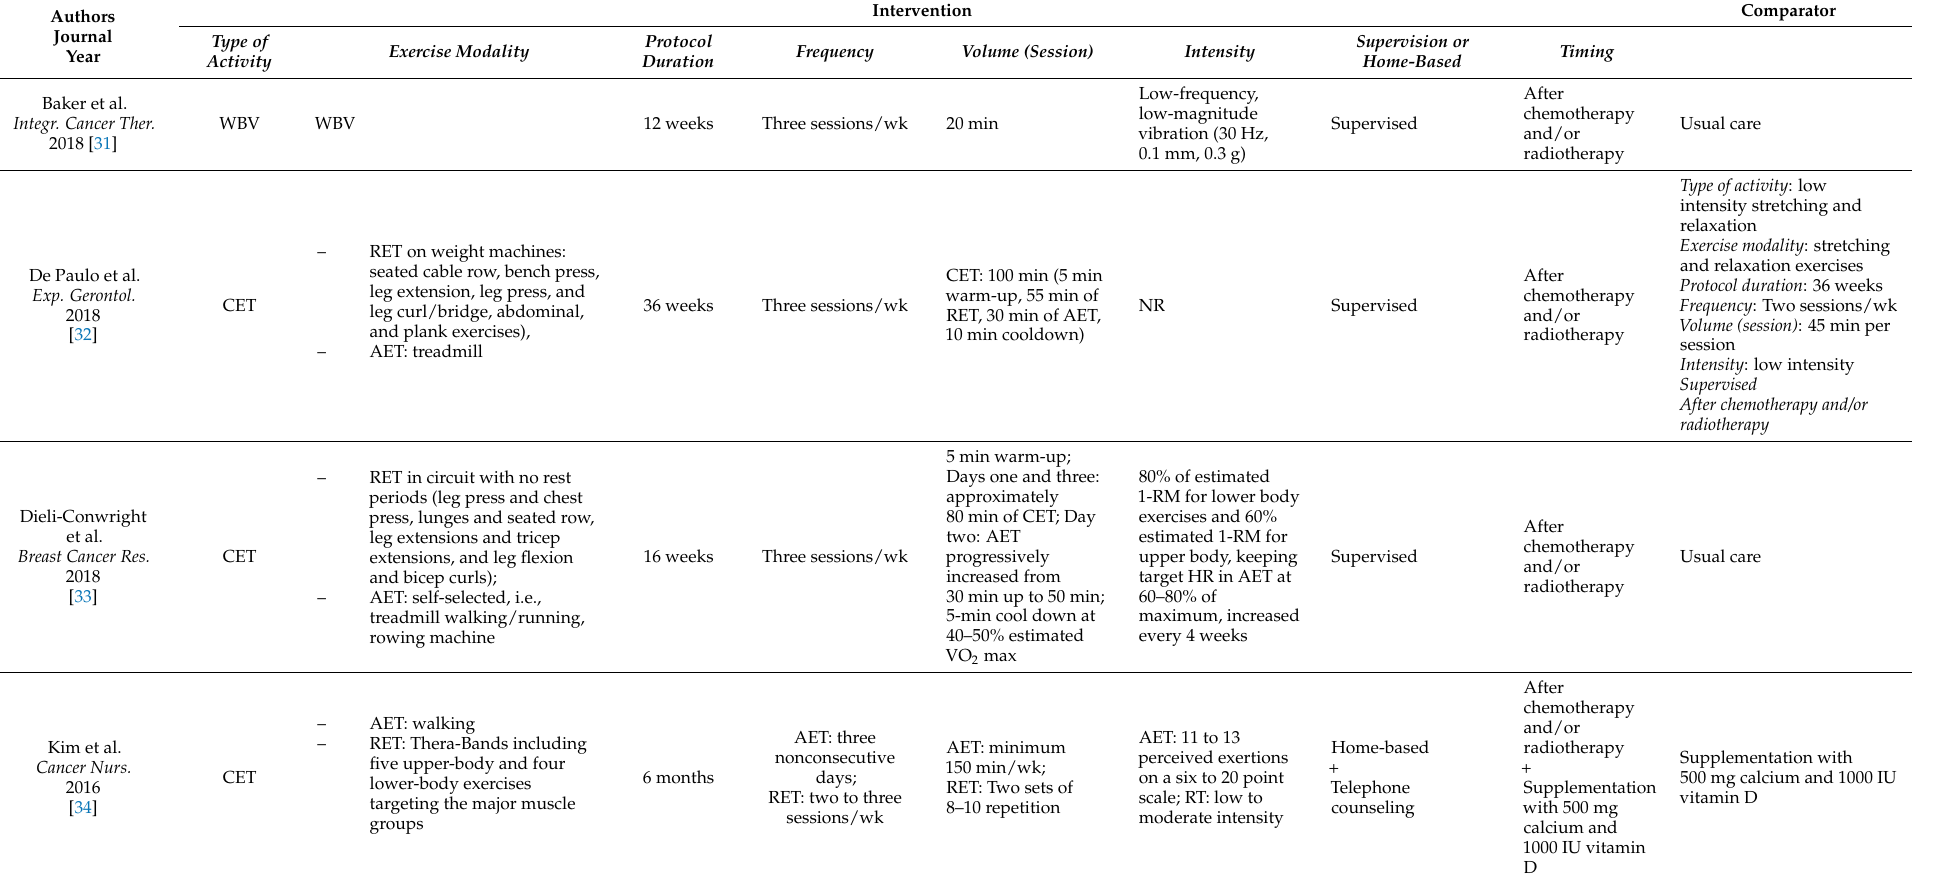
Table 3. Main characteristics of the study